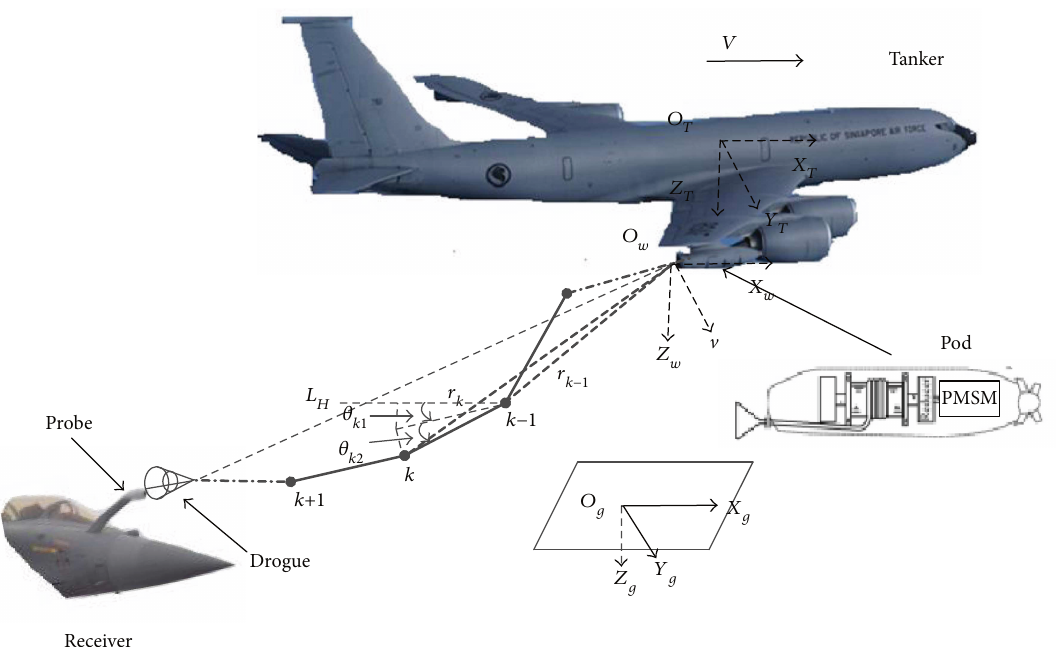
Figure 2: The con fi guration and variable length modeling of a hose-drogue aerial refueling